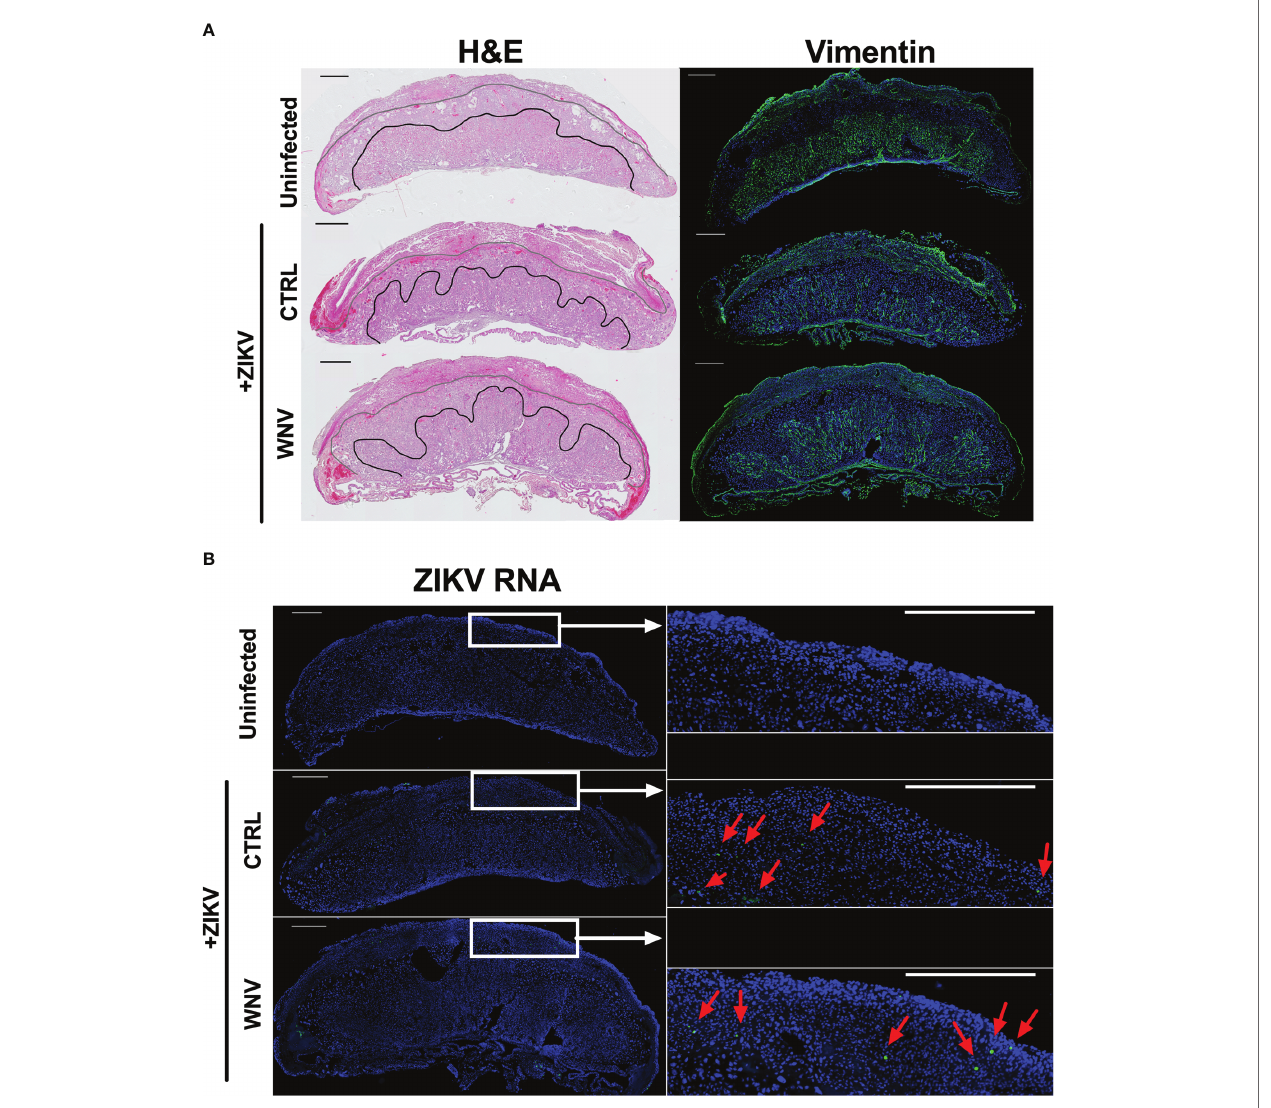
FIGURE 5 | ZIKV-induced damage in the developing placenta. Placentas harvested at E13.5 from uninfected of ZIKV-infected dams that received either WNV or CTRL plasma were examined for (A) the disruption of the placental labyrinth zone by both hematoxylin and eosin (H&E) staining (left) and immuno fl uorescence staining for vimentin (right), which marks fetal endothelium (green). DAPI is shown in blue. (B) Placentas were evaluated for ZIKV RNA localization by in situ hybridization. Tiled images of representative whole placentas are shown on the left, with tiles from white boxed regions shown on the right for ease of comparison (scale = 500µm). ZIKV-infected cells (green) are highlighted with red arrows and DAPI is shown in